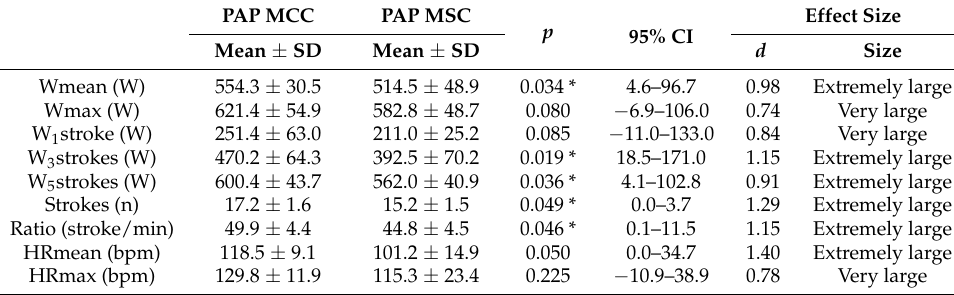
Table 2. Results of the 20 s sprint test